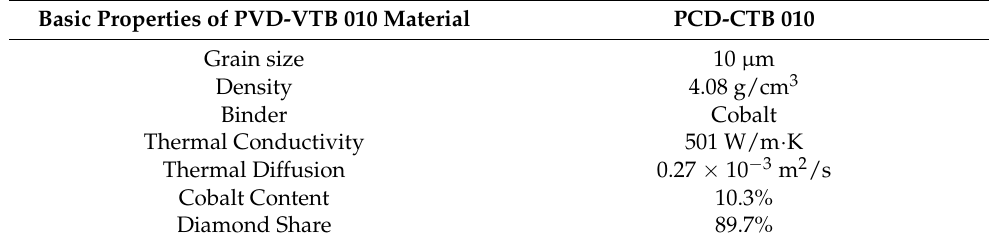
Table 2. Basic properties of PCD material [14].